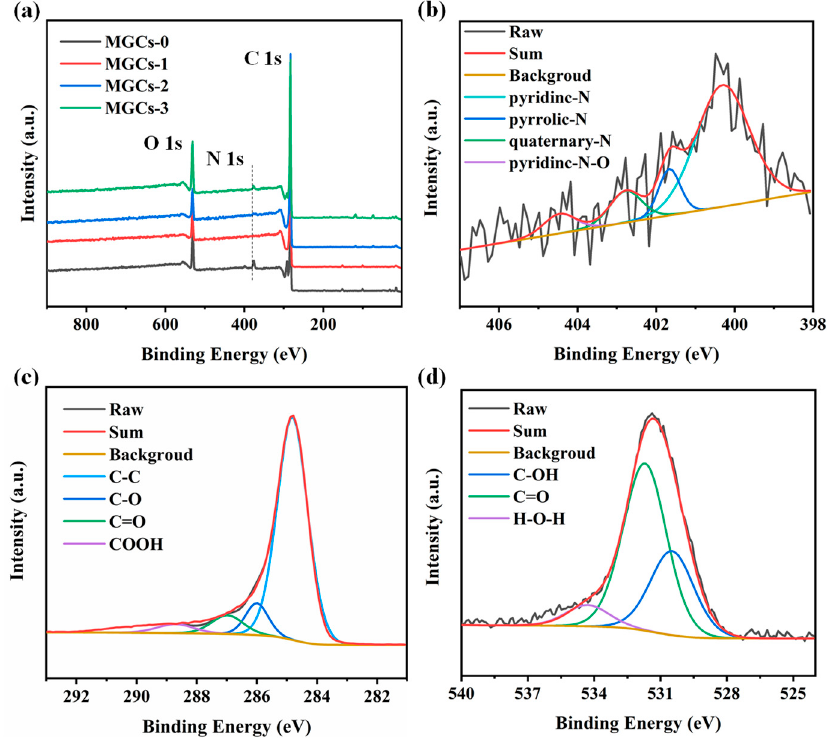
Figure 4. ( a ) Survey XPS spectra and high-resolution XPS spectra of ( b ) N 1 s; ( c ) C 1 s; and ( d ) O 1 s of MGCs-2.